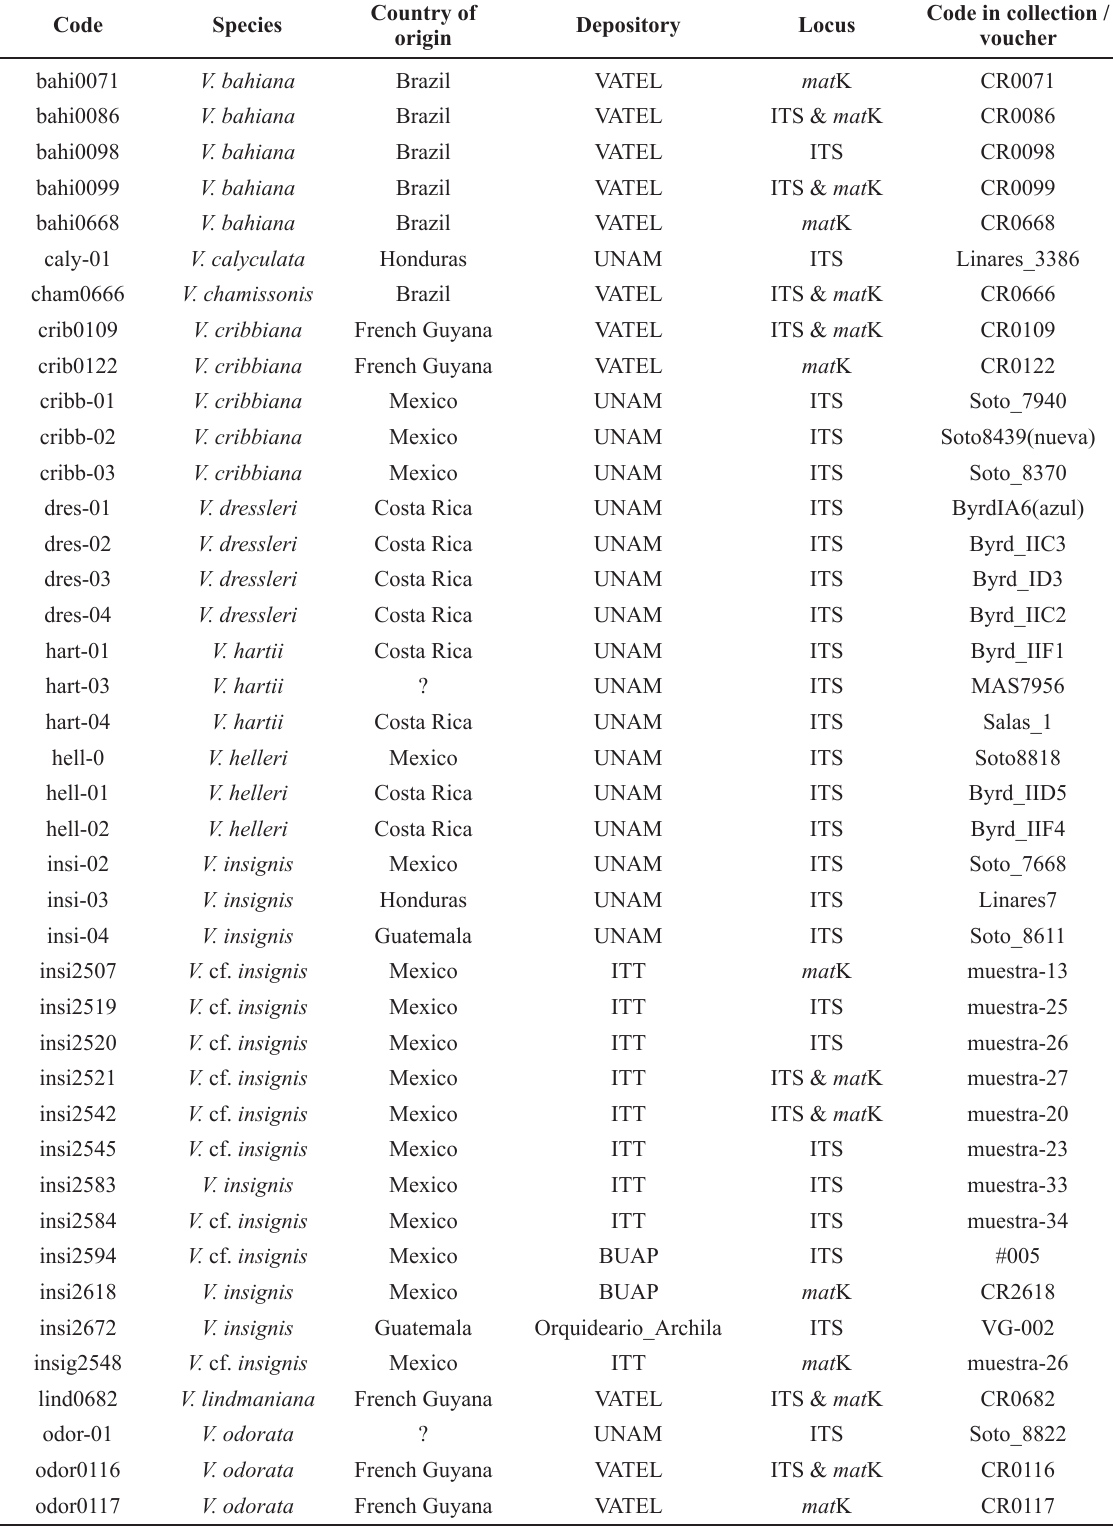
Table 1. Identification and origin of the accessions of species of Vanilla Plum. ex Miller used in this study. [continued on next 3